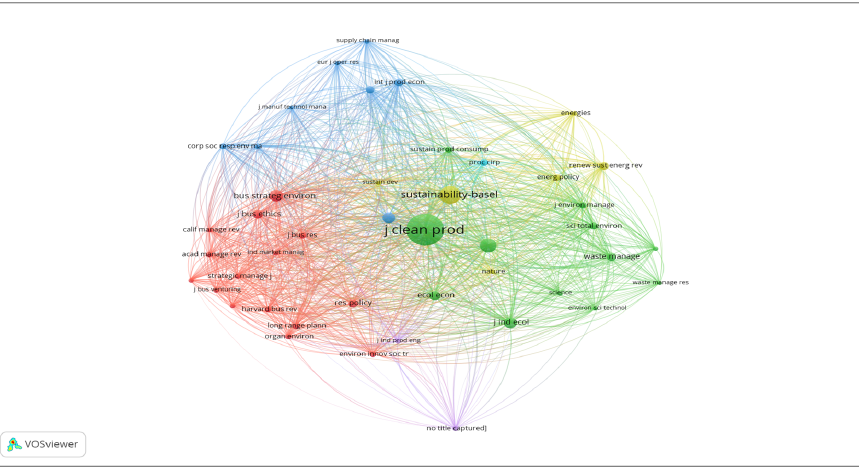
Figure 10. VOSviewer diagram containing the most important author keywords for the couple: social innovation and circular*.